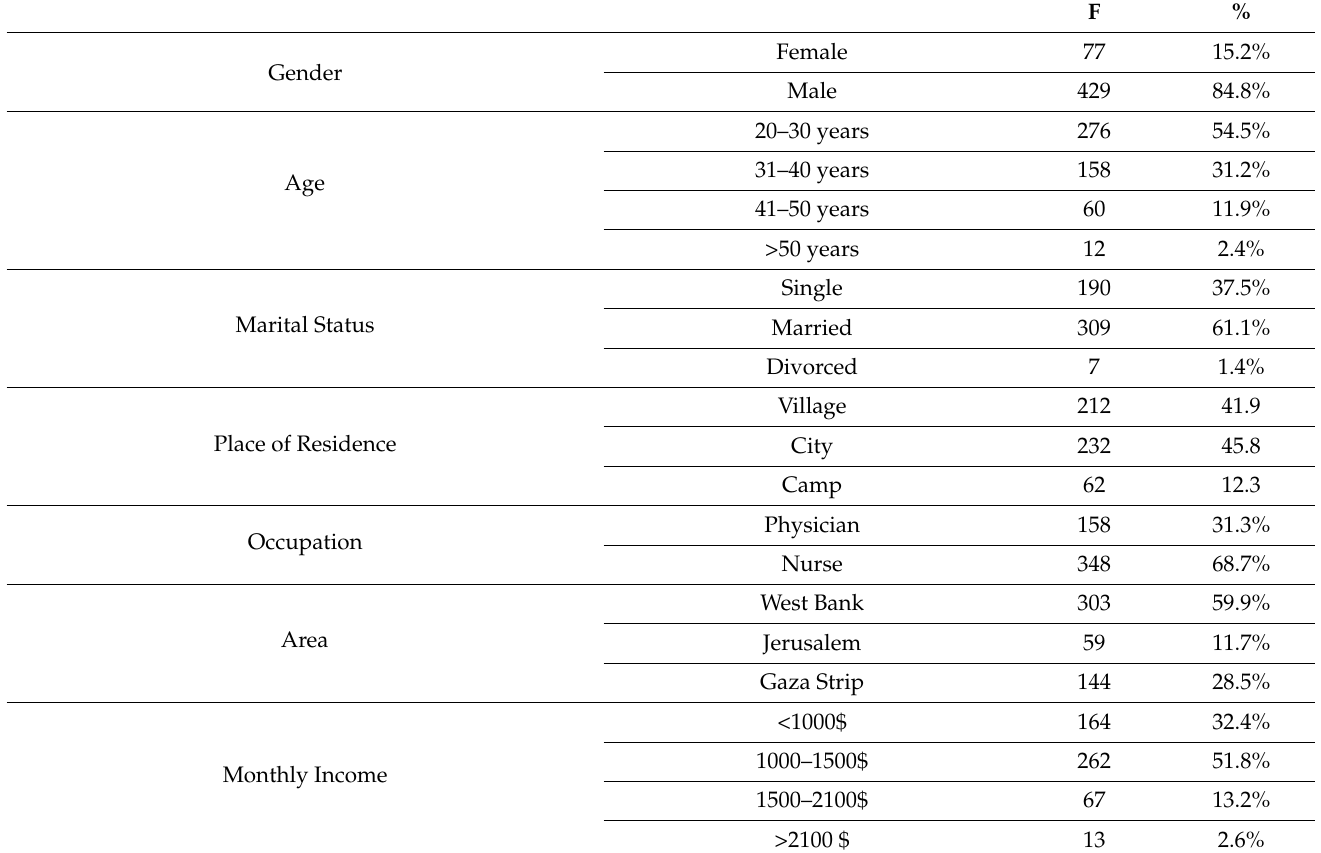
Table 1. Participants’ demographic characteristics and experience with